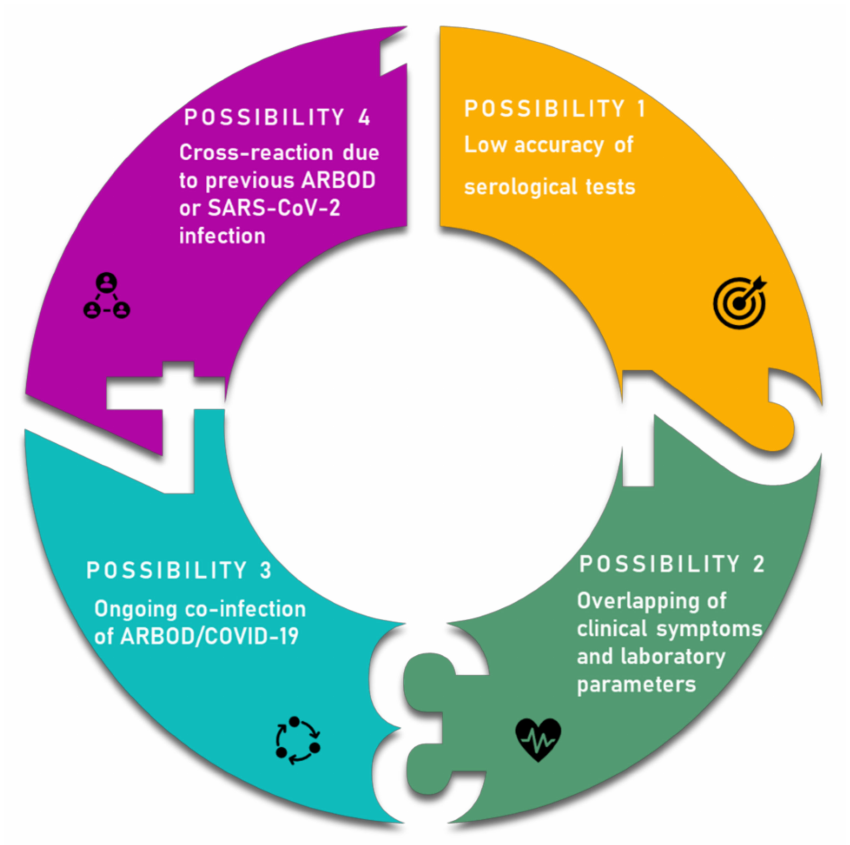
Figure 2. The main hypotheses that may be related to misdiagnosis between COVID-19 and ar- boviruses